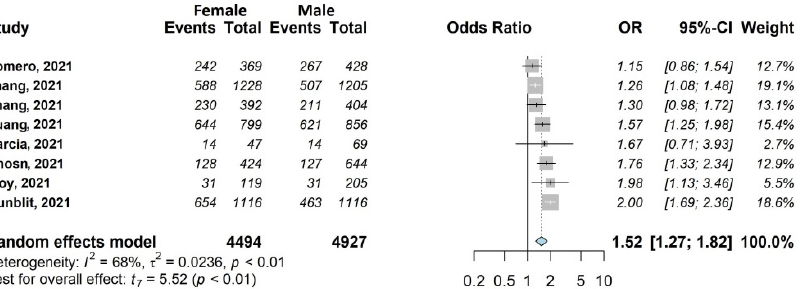
Figure 2. Forest plots of adjusted analyses for association between sex (female) and any Symptoms. HKSJ, Hartung-Knapp-Sidik-Jonkman.